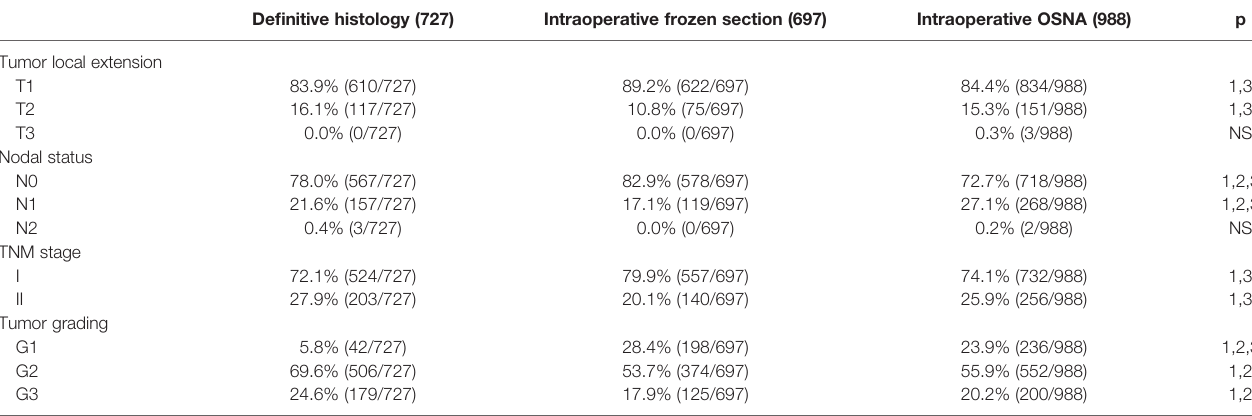
TABLE 3 | TNM stage and tumor grading among the three considered groups (de fi nitive histology, intraoperative frozen section, and OSNA).